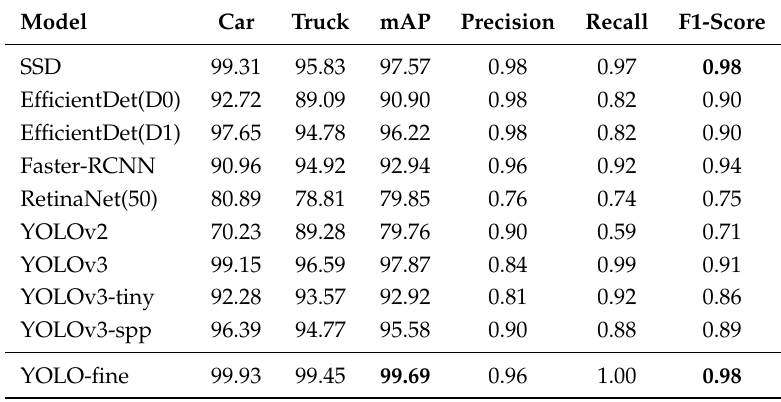
Table 6. Detection results on MUNICH. Best results of mAP and F1-score in